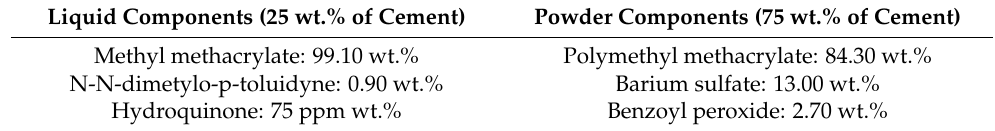
Table 1. Composition of Cemex Isoplastic cement.